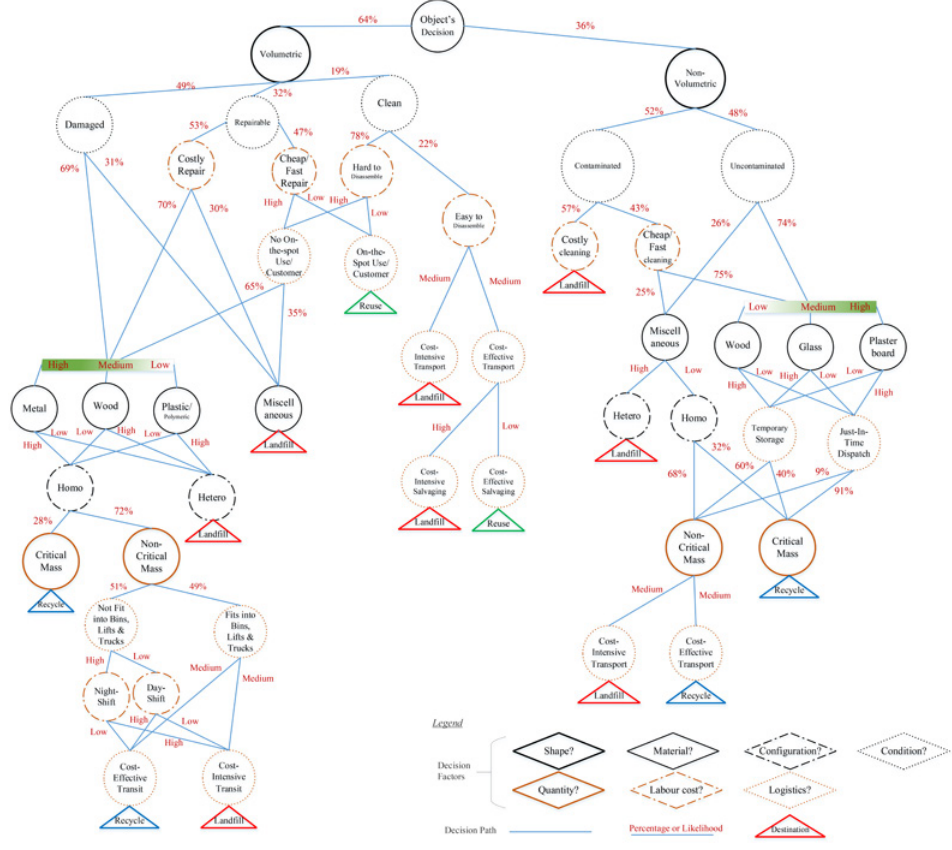
Figure 5 Dynamics of decision making on demolition of fit-out elements